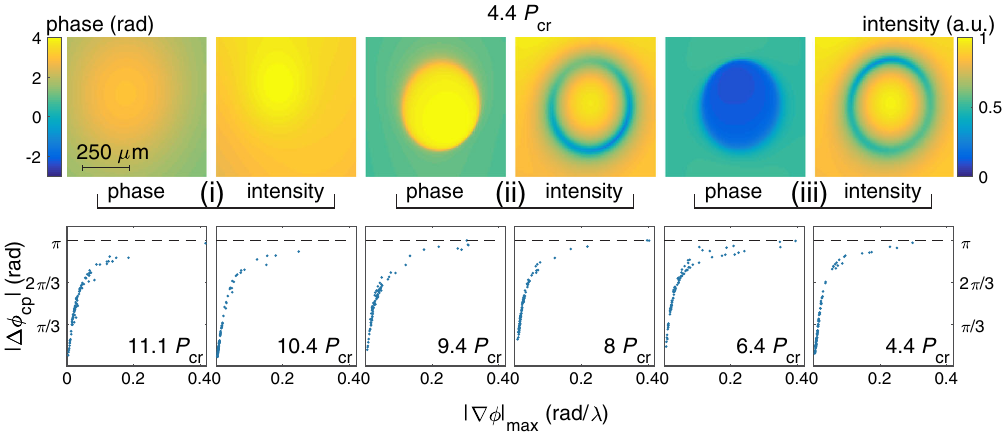
4 . 4 for (i) a cr ¼ cr